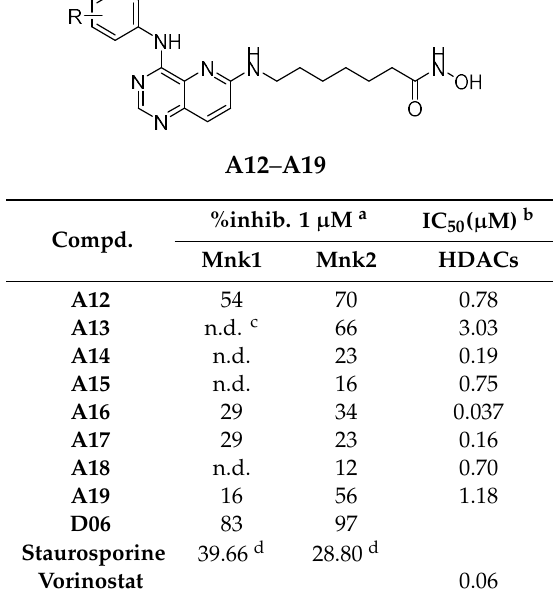
Table 2. In vitro enzyme inhibitory activity of target compounds A12 – A19 . %inhib. 1 μM Compd.